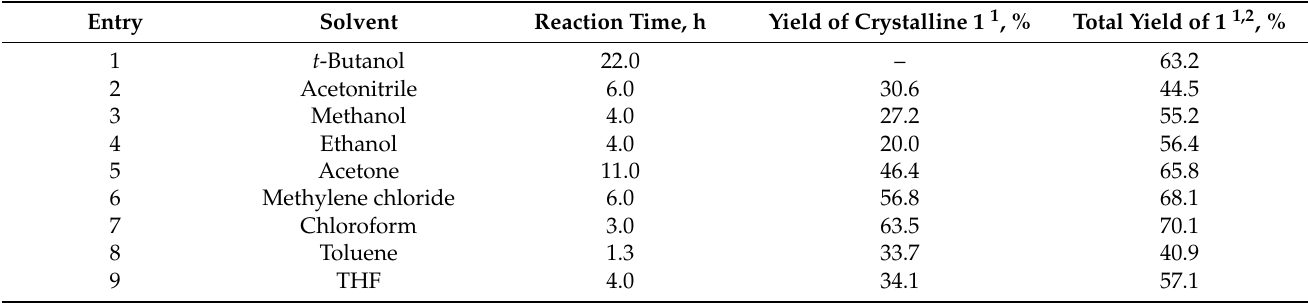
Table 3. Effects of solvents on reaction time and yield of compound 1